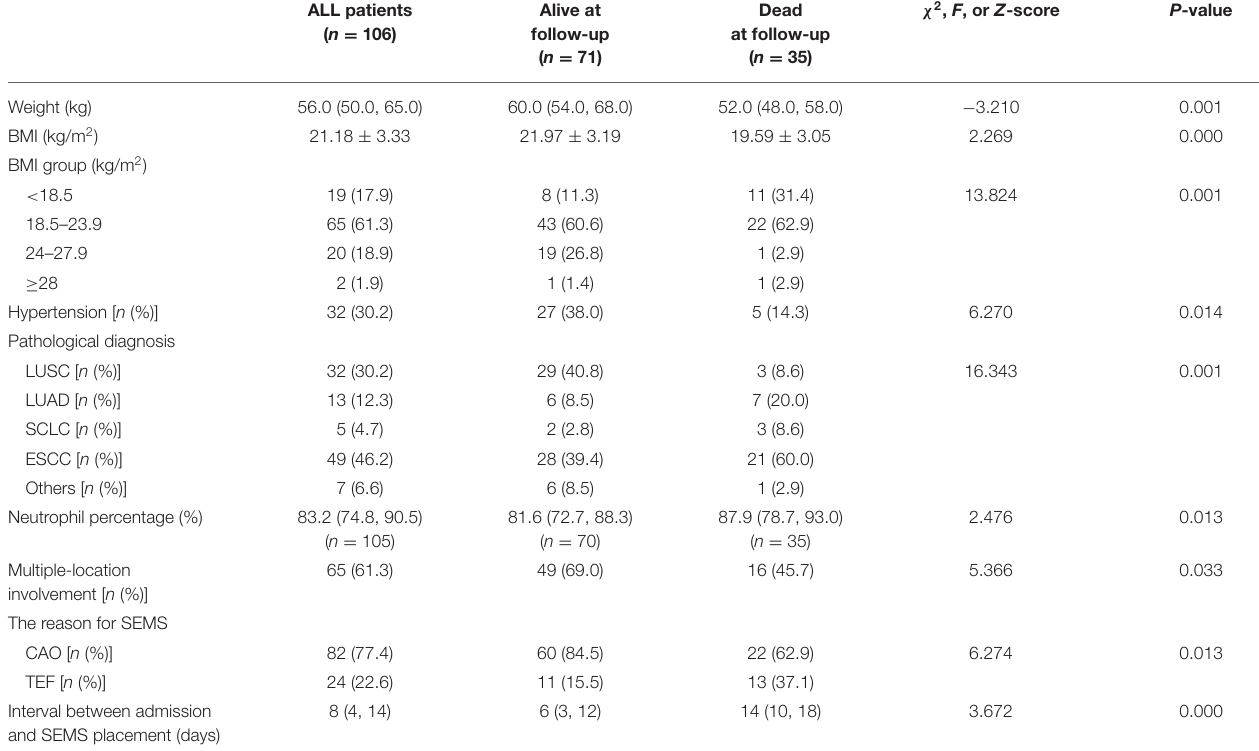
TABLE 4 | The clinical features in patients with malignant airway disorders receiving SEMS placement in which significant differences were found when the patients were divided in two groups (alive or dead three months later).